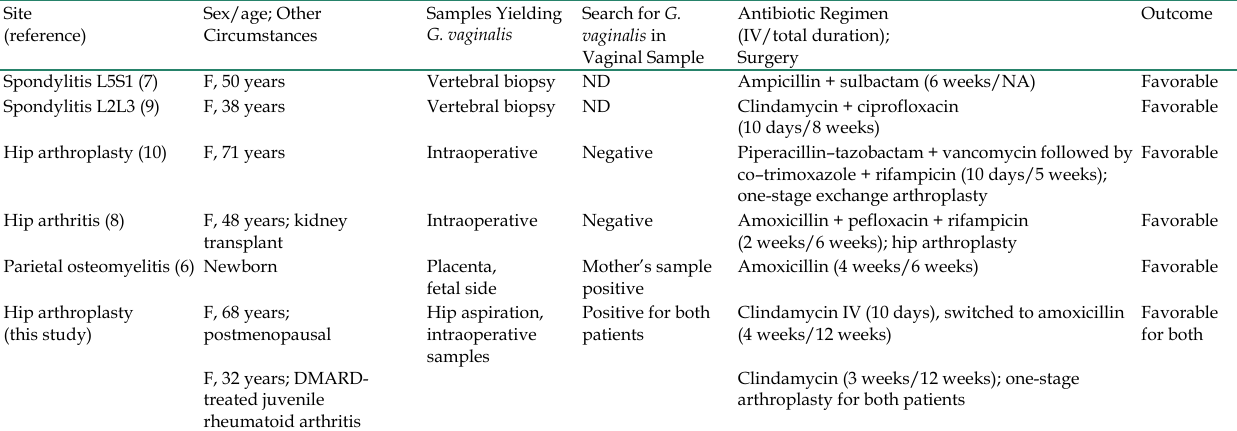
Samples Yielding G. vaginalis